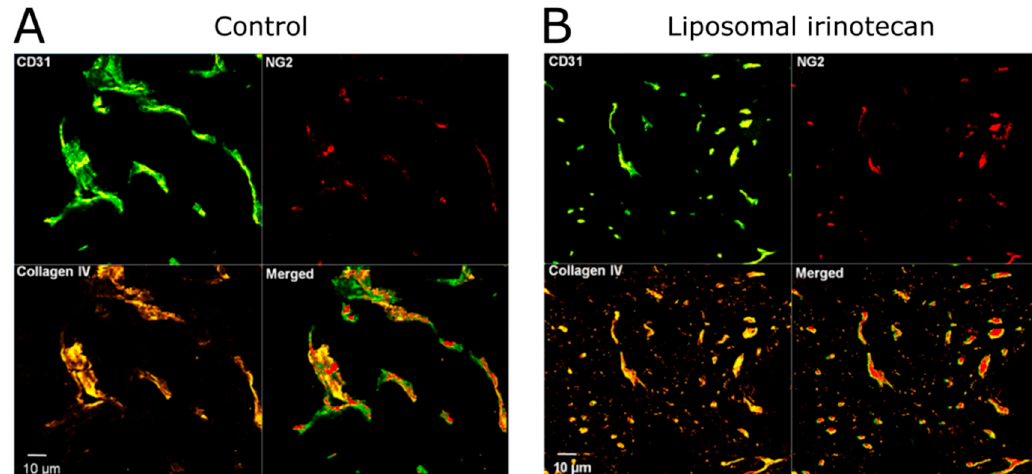
Figure 4. Normalisation of tumour neovasculature by liposomal irinotecan in a mouse model of glioblastoma. After treatment with liposomal irinotecan (Irinophore C™) once weekly for 3 weeks, Verreault et al. recognised a significant reduction of the diameters of tumour blood vessels (identified by the CD31 marker, in green) in the subcutaneous glioblastoma xenograft. In contrast, the number of pericytes (NG2, in red) and the basement membrane coverage of blood vessels (collagen IV, in yellow) increased after the therapy. Taking the data together, fewer immature tumour vessels (CD31 + , NG2 − , and collagen IV − ) were present in the TME after administration of liposomal irinotecan. Adapted with permission from [41]. Copyright 2011 by Verreault et al.